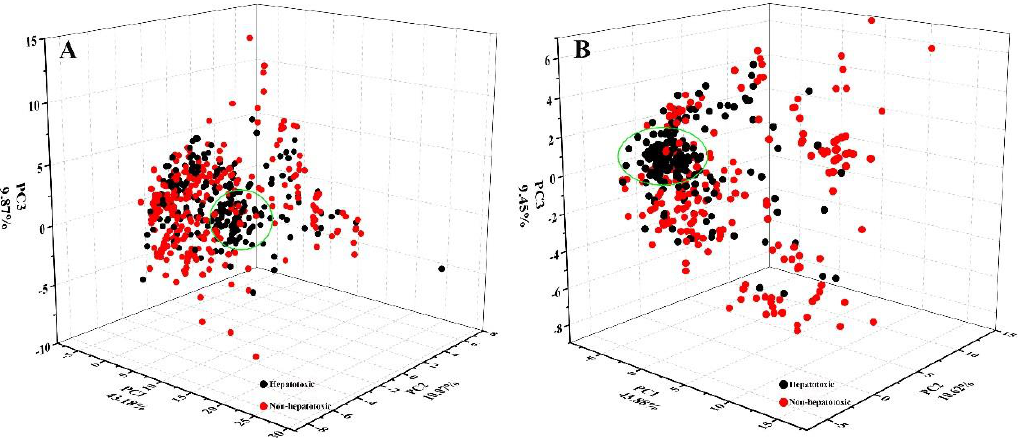
Figure 2. The chemical spaces of hepatotoxic and non-hepatotoxic ingredients.